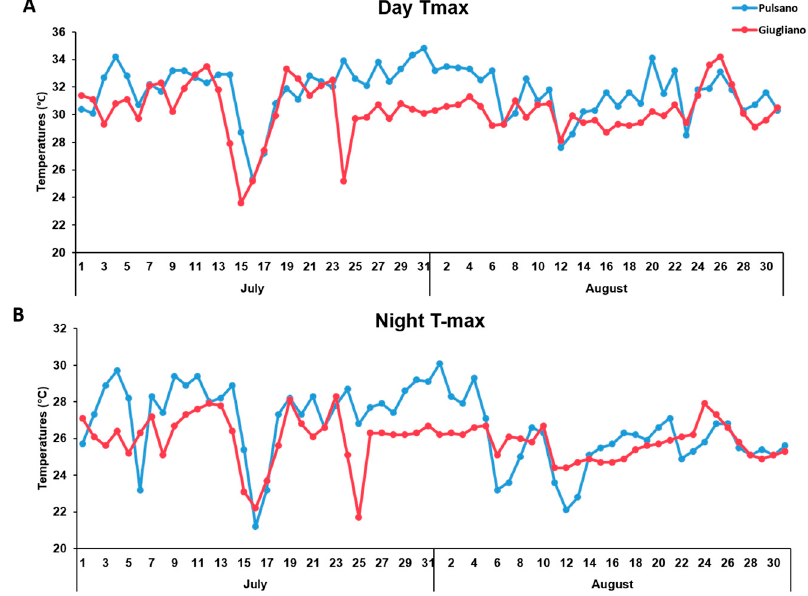
Figure 2. Maximum temperatures recorded in the experimental fields located in Giugliano and Pulsano during the day ( A ) and the night ( B ) from June to August 2016.